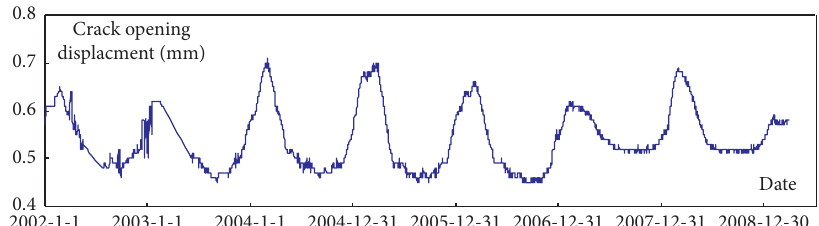
Figure 2: Measured data curve of crack opening displacement.